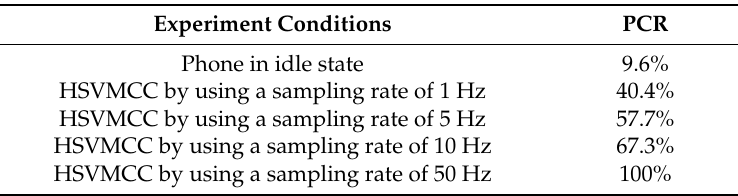
Table 6. PCR in different experiment conditions.